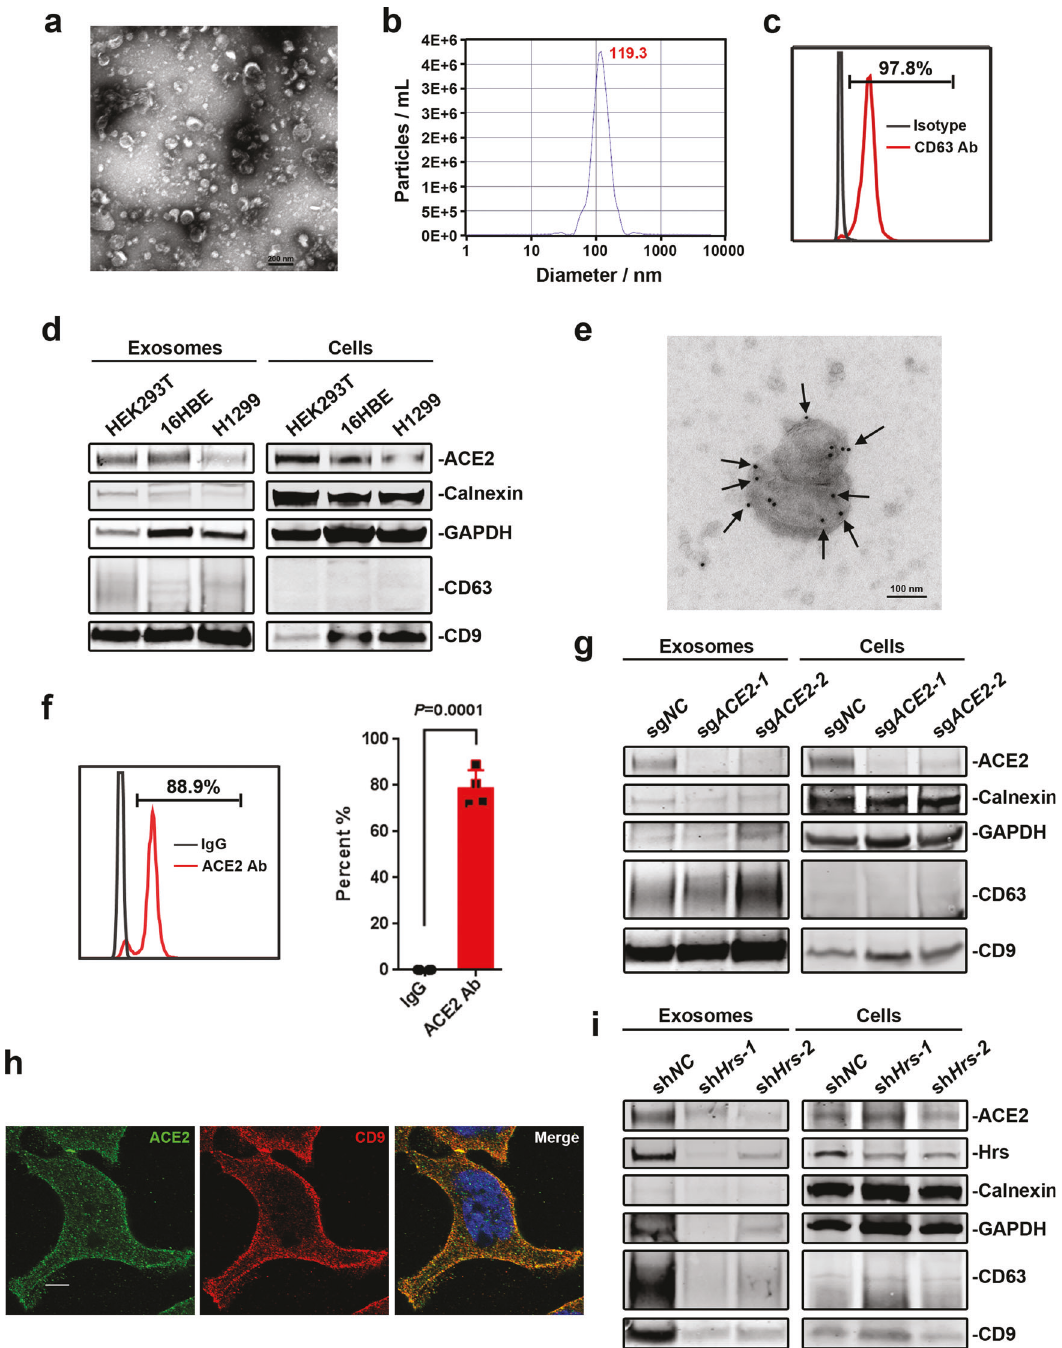
Fig. 1 hACE2 is speci fi cally expressed on the surface of exosomes. a A representative of TEM image of exosomes puri fi ed from HEK293T cells. Scale bar, 200 nm. b The size and concentration of puri fi ed exosomes derived from HEK293T cells by NTA. The size of 97.5% of total puri fi ed exosomes is about 119.3 nm. c The puri fi ed exosomes derived from HEK293T cells were further enriched with Human CD63 Isolation/ Detection Reagent and stained with anti-CD63 antibody, followed by fl ow cytometry analysis. d Western blot analysis of the whole cell lysates (Cells) and puri fi ed exosomes (Exosomes) from HEK293T, 16HBE, and H1299 cells. e A representative TEM image of HEK293T cell-derived exosomes immunogold-labeled with anti-ACE2 antibodies. Two exosomes close together were shown in the picture. Arrowheads indicate 10 nm gold particles. Scale bar, 100 nm. f The puri fi ed exosomes derived from HEK293T cells were further enriched with Human CD63 Isolation/Detection Reagent and stained with anti-ACE2 antibody, followed by fl ow cytometry analysis (Left panel). Right: Frequency of ACE2 + exosomes in left. Data were shown as the mean ± SD of four independent experiments, and compared using the two-tailed student ’ s t test. *** P < 0.001. g Western blot analysis of the whole cell lysates and puri fi ed exosomes from sg ACE2 knockdown cell lines or control cell line. h The confocal image of intracellular hACE2 and exosome marker CD9 in HEK293T. The cells were stained with anti-ACE2 (green) and anti-CD9 (red) antibodies. The nucleus was stained with DAPI (blue). Scale bars, 5 μ m. i Western blot analysis of the whole cell lysates and puri fi ed exosomes from sh Hrs knockdown cell lines or control cell